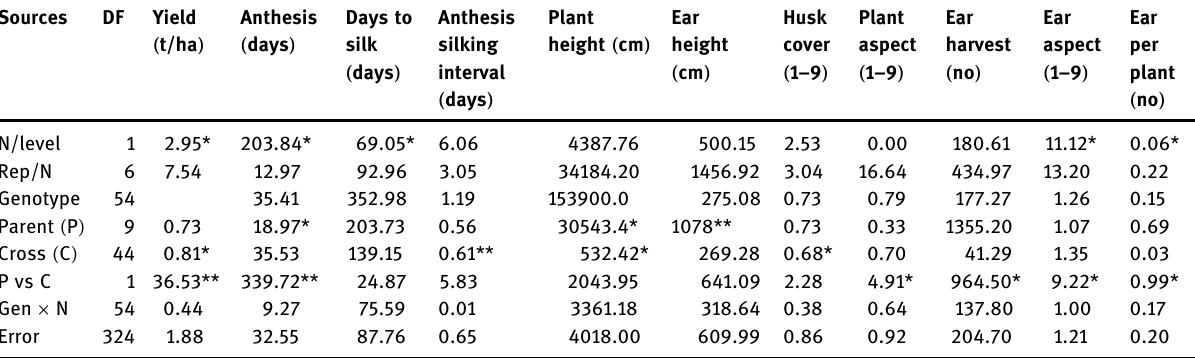
Table 2: ANOVA for grain yield and agronomy traits in F 1 hybrids and parents under low - N versus high - N at Mokwa and Zaria ( 2012 ) Sources